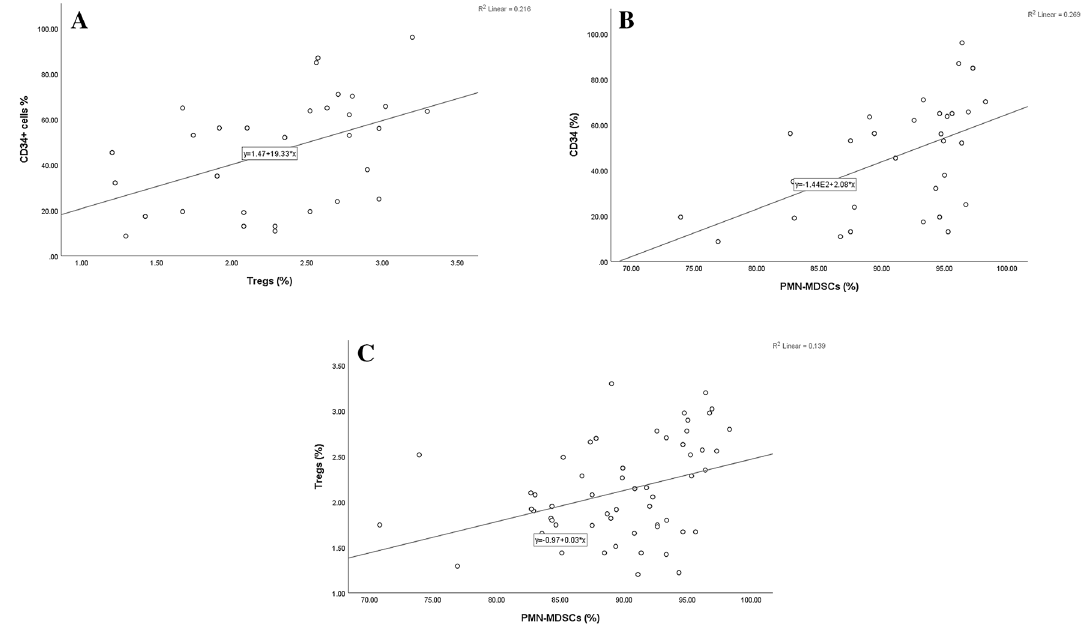
Figure 3. CD34 + cells showing direct relations with the levels of Tregs in ( A ) and MDSCs in ( B ) and a direct association between the levels of Tregs and PMN-MDSCs was shown in ( C ).